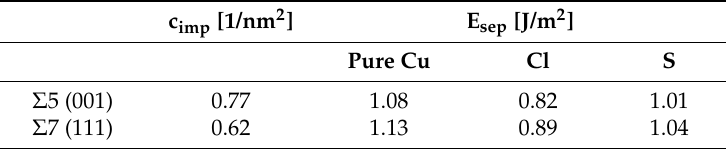
Table 2. Calculated work of separation E sep of Σ 5 and Σ 7 grain boundaries of pure Cu and Cu contaminated with Cl and S with planar impurity concentration c imp in atoms per nm 2